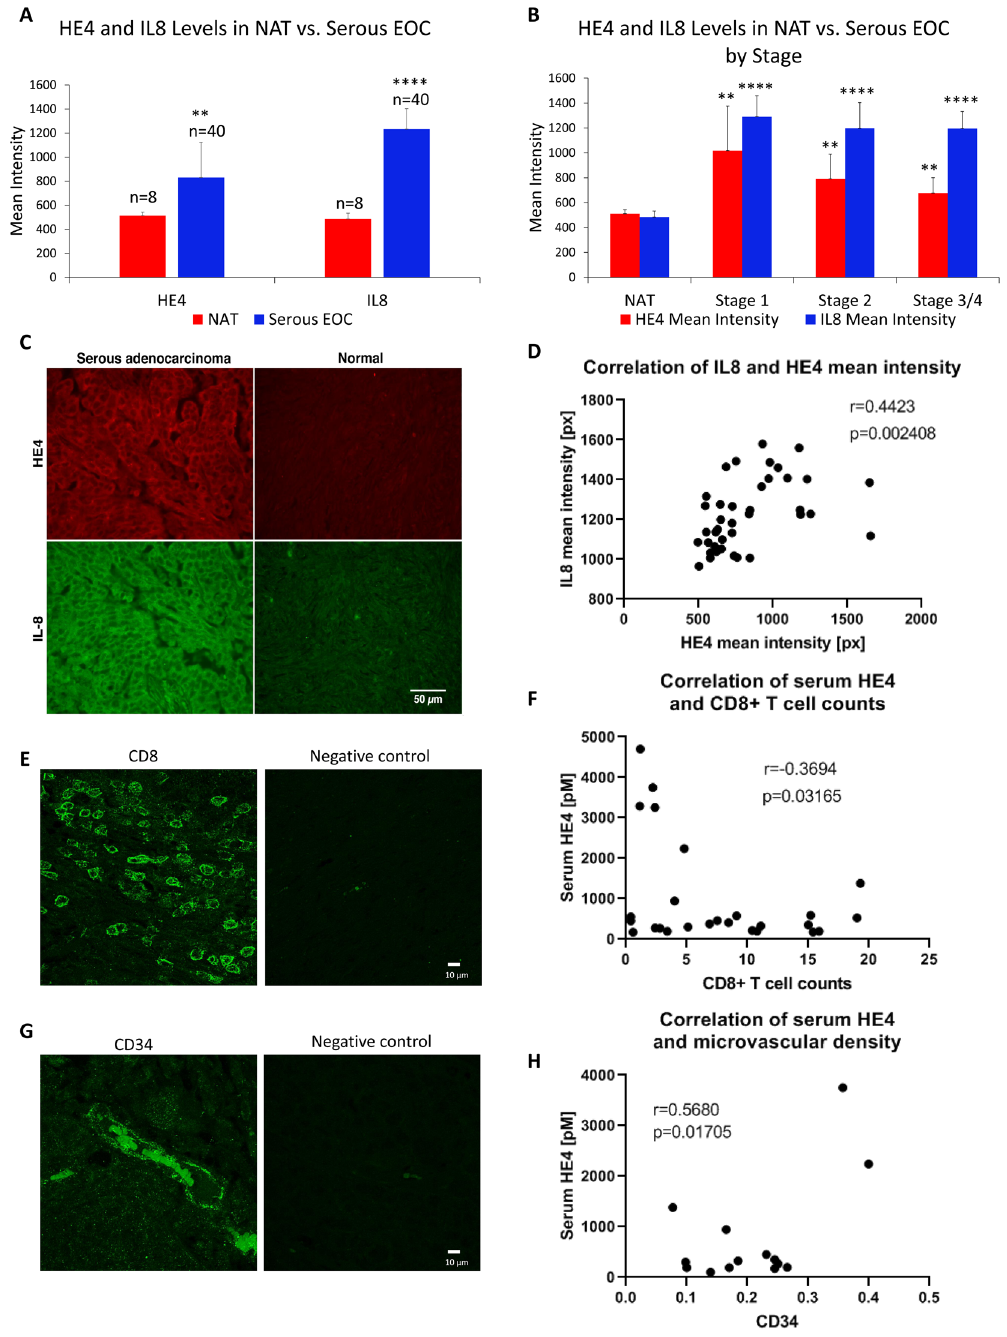
Figure 5. ( A ) HE4 and IL8 tissue levels are elevated in serous EOC compared to normal adjacent tissue (NAT) ( B ) HE4 and IL8 tissue levels are elevated in serous EOC at all stages compared to NAT. (C) Representative images of HE4 and IL8 staining in EOC tissue and NAT. (D) Tissue HE4 and IL8 levels (mean intensity) are positively correlated in serous EOC. (E) CD8 + T cells in serous EOC tissue. (F) Inverse correlation between HE4 serum levels and CD8 + T cell counts in patient EOC tissue (n = 26). (G) CD34 + microvascular staining in EOC tissue. (H) Correlation between HE4 serum levels and CD34 + area in patient EOC tissue (n = 14). ** p < 0.005, **** p <